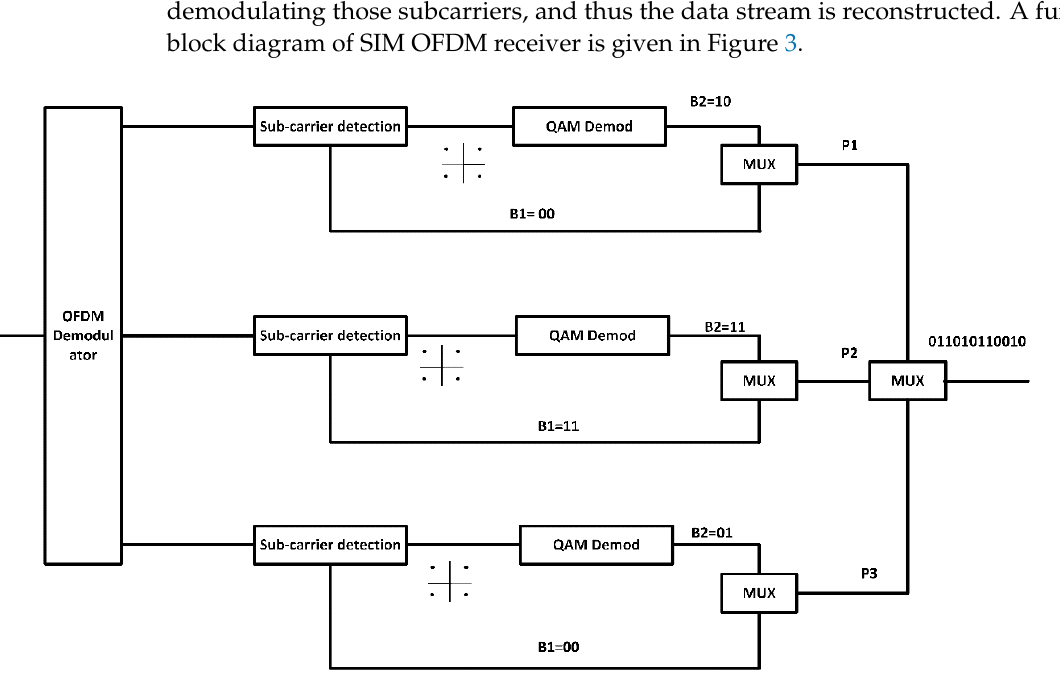
Figure 3. System block diagram of SIM OFDM receiver.